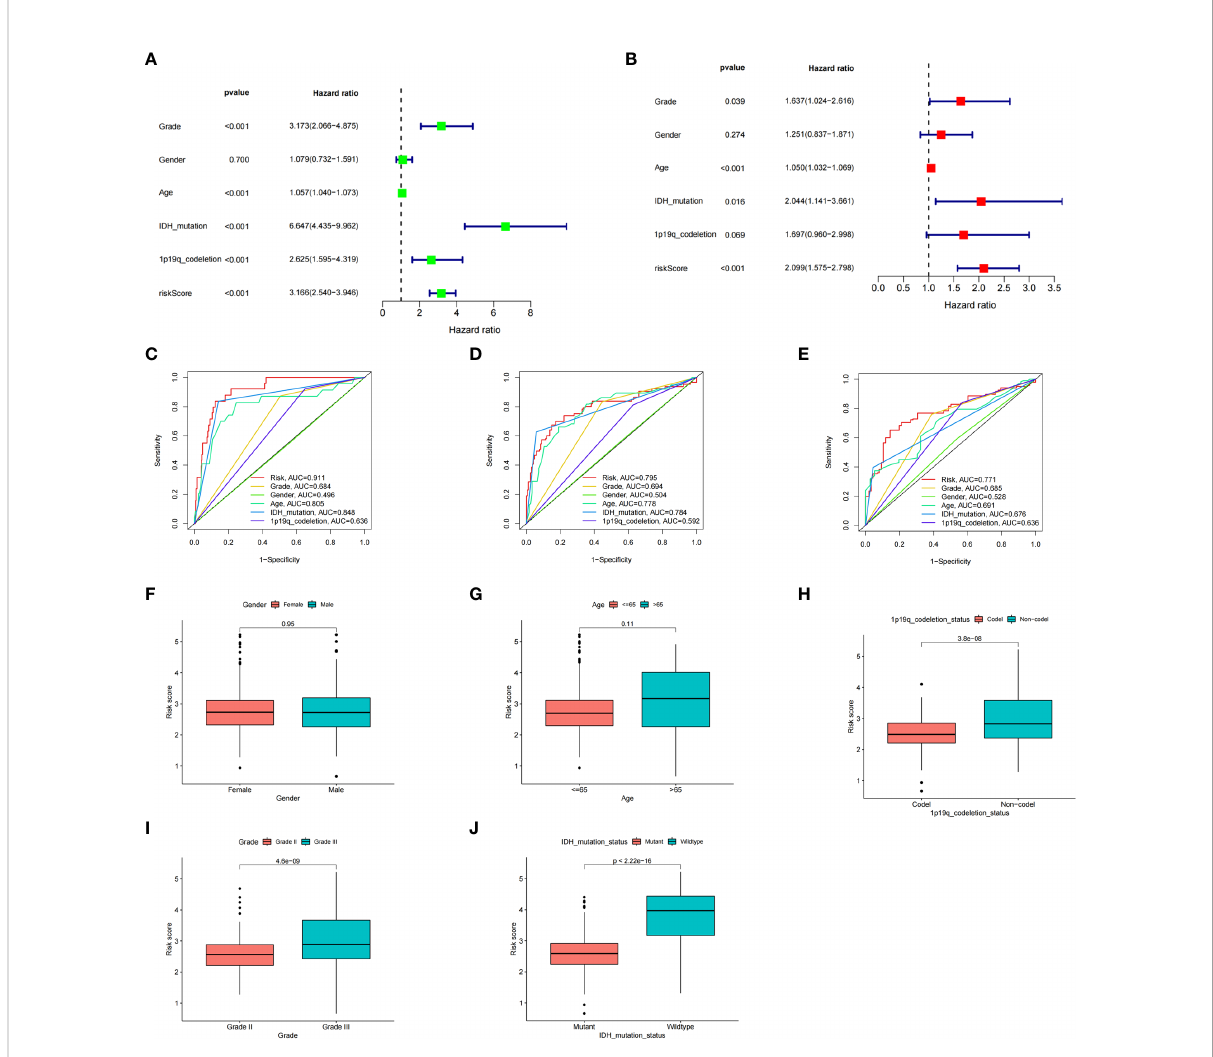
FIGURE 5 The prognostic value of the risk score and the association between risk score and clinicopathological factors. (A) Forest plot of the univariate Cox test evaluating the association of the risk score and clinical factors with patient OS. (B) Forest plot of the multivariate Cox analysis identifying independent risk factors for the OS of patients. (C – E) The ROC curve of the risk score and clinical factors for predicting 1- (C) , 3- (D) , and 5-year (E) OS. (F – J) Distribution of ICD-related risk scores among LGG patients strati fi ed by gender, age, 1p/19q codeletion status, WHO grade, and IDH mutation status in TCGA